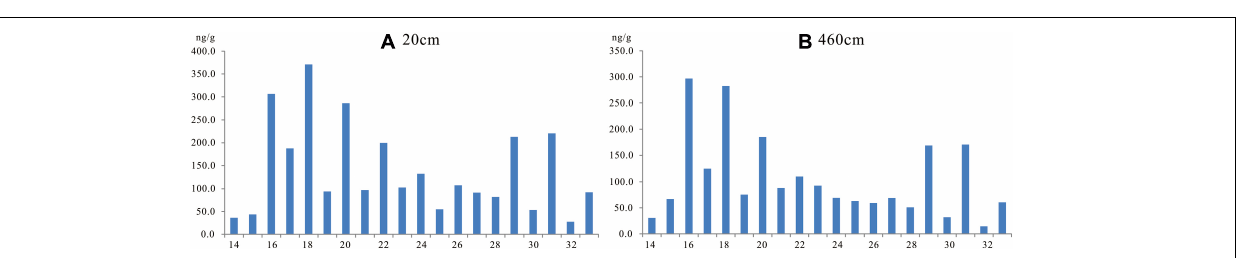
FIGURE 6 | Distribution of n -alkanes in the representative horizon in the core sediments (A,B) .